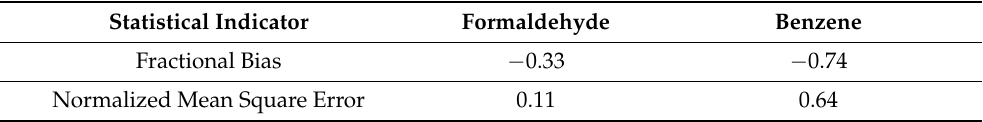
Table 17. Air Dispersion Model Performance